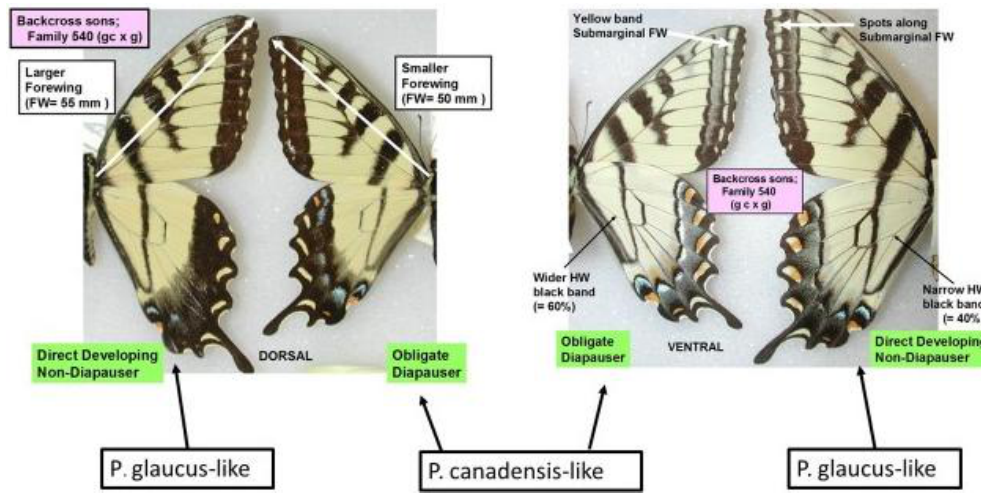
Figure 12. Typical wing patterns of backcross sons (siblings) showing segregation of P . canadensis -like traits (e.g., relatively wider hindwing band widths in the anal cell) with diapause and P . glaucus -like traits with direct development. The z-linked P . glaucus -like Ldh-100 allozyme is closely linked with the od- gene for facultative diapause (95% of females that directly developed), while the P . canadensis -like Ldh-80 and Ldh-40 alleles were linked with the obligate diapause gene (od+)